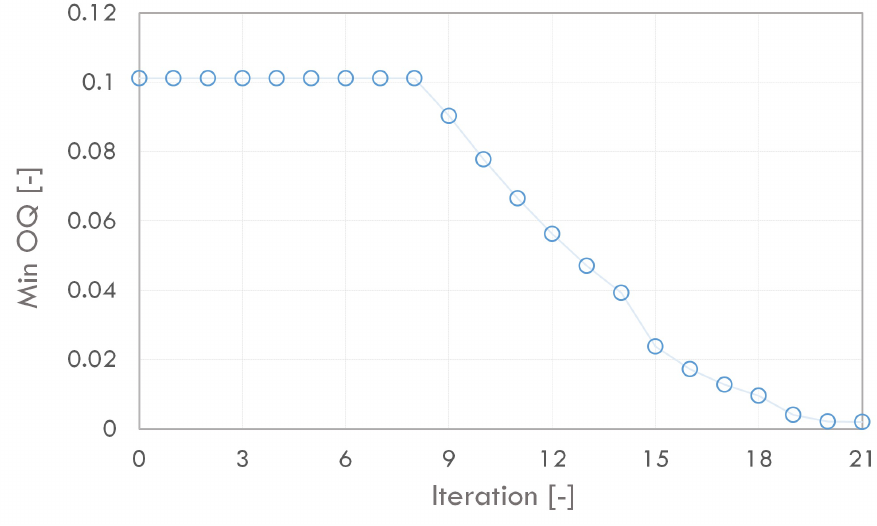
Figure 22. Change in minimum orthogonal quality over successive iterations.